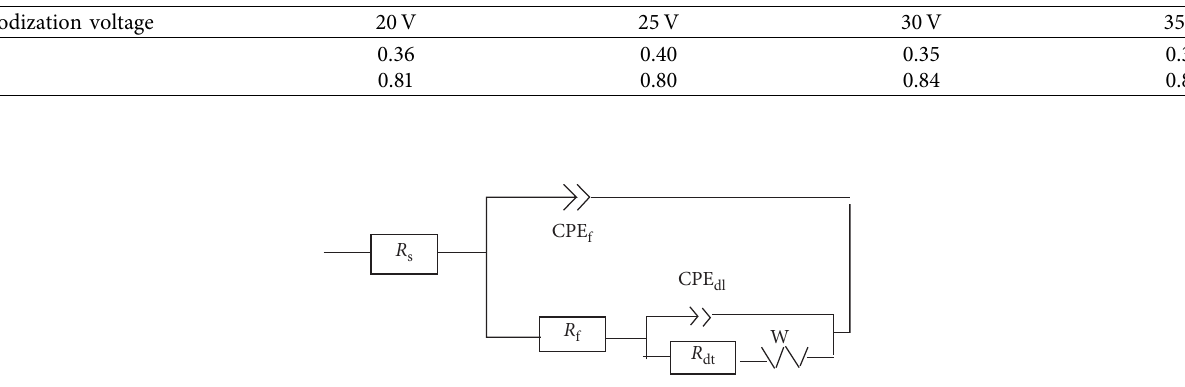
Figure 12: Electrical equivalent circuit for the as-anodized Ti-Cu (2%) alloy.